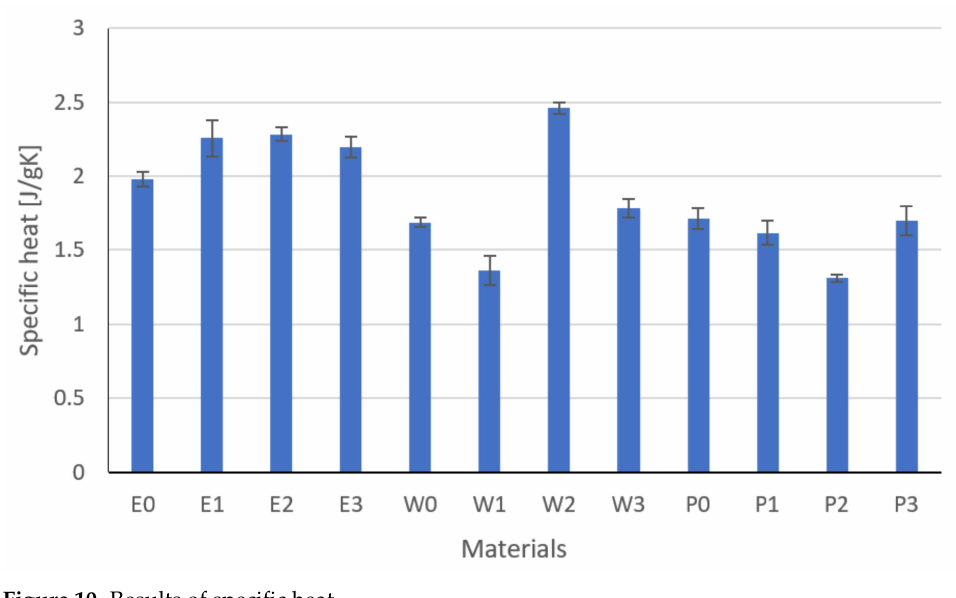
Figure 10. Results of specific heat.